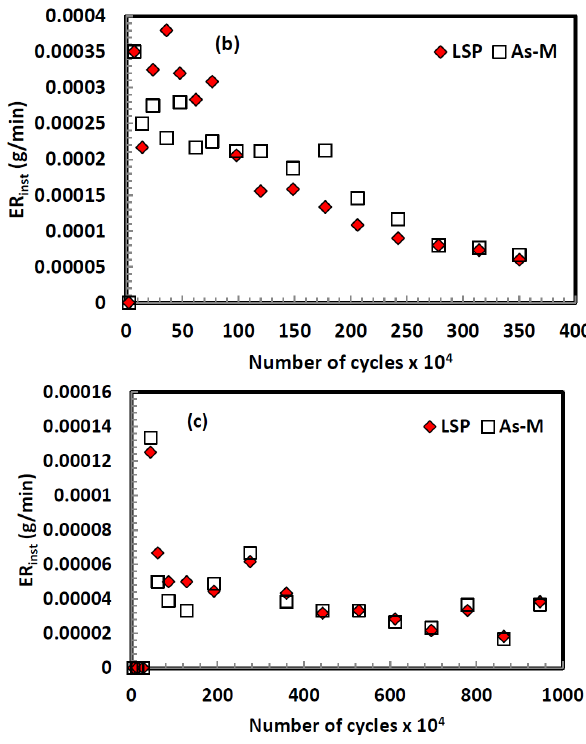
Figure 13. ER inst for WDE tests using ( a ) 350 m/s, 460 μ m; ( b ) 300 m/s, 460 μ m and ( c ) 350 m/s, 200 μ m.